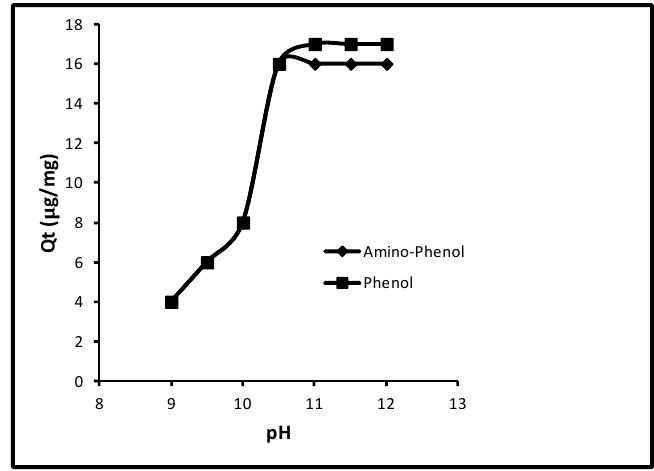
Figure 4. Effect of pH of the solutions of phenols.